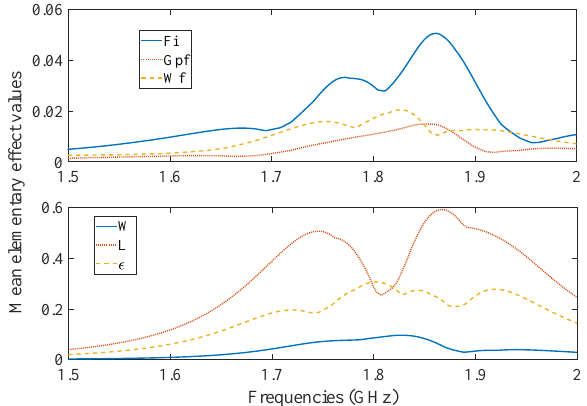
Figure 9. Mean elementary effects of the path-antenna problem for the first case.